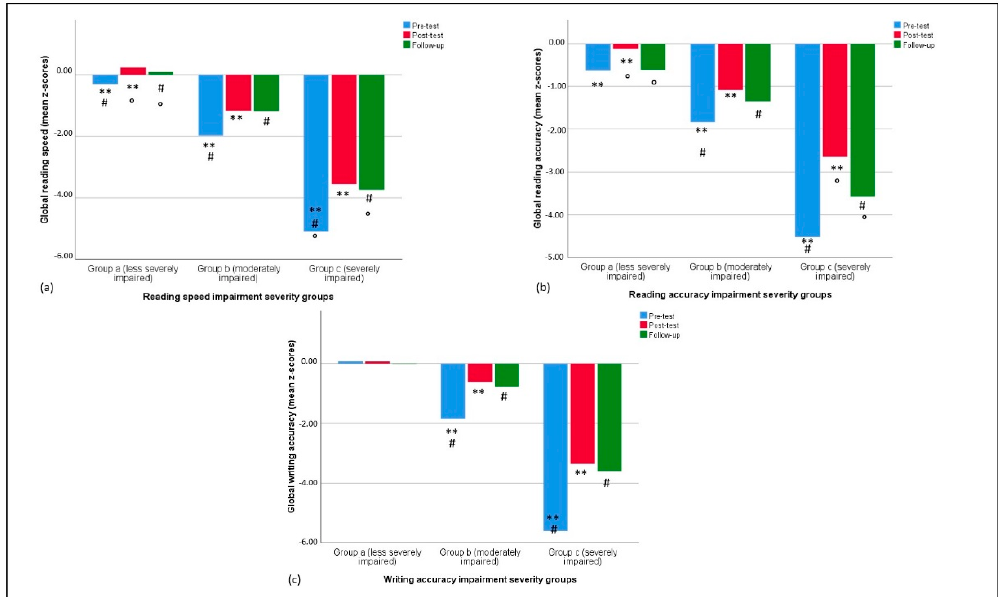
Figure 5. Pre-test, post-test, and follow-up reading and writing scores in the three different impairment severity groups. Identical symbols (**, °, #) indicate pairs of significantly different variables within each between-groups comparison.